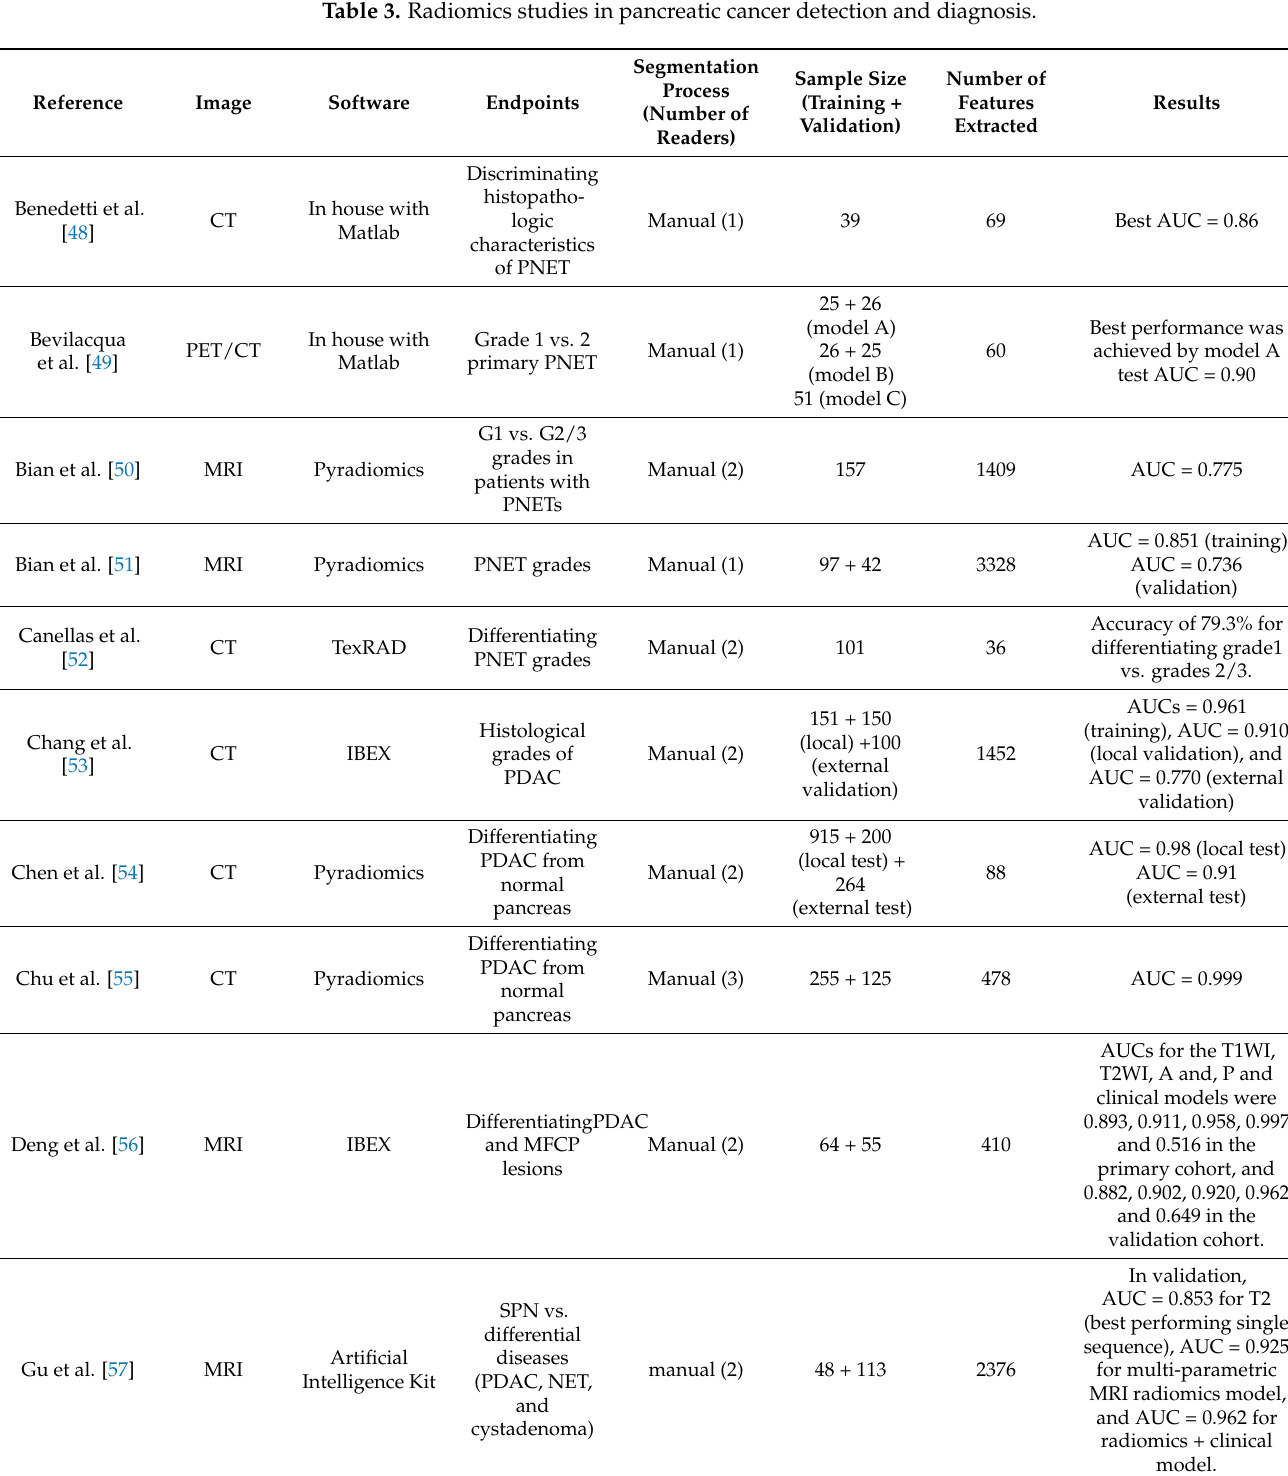
Table 3. Radiomics studies in pancreatic cancer detection and